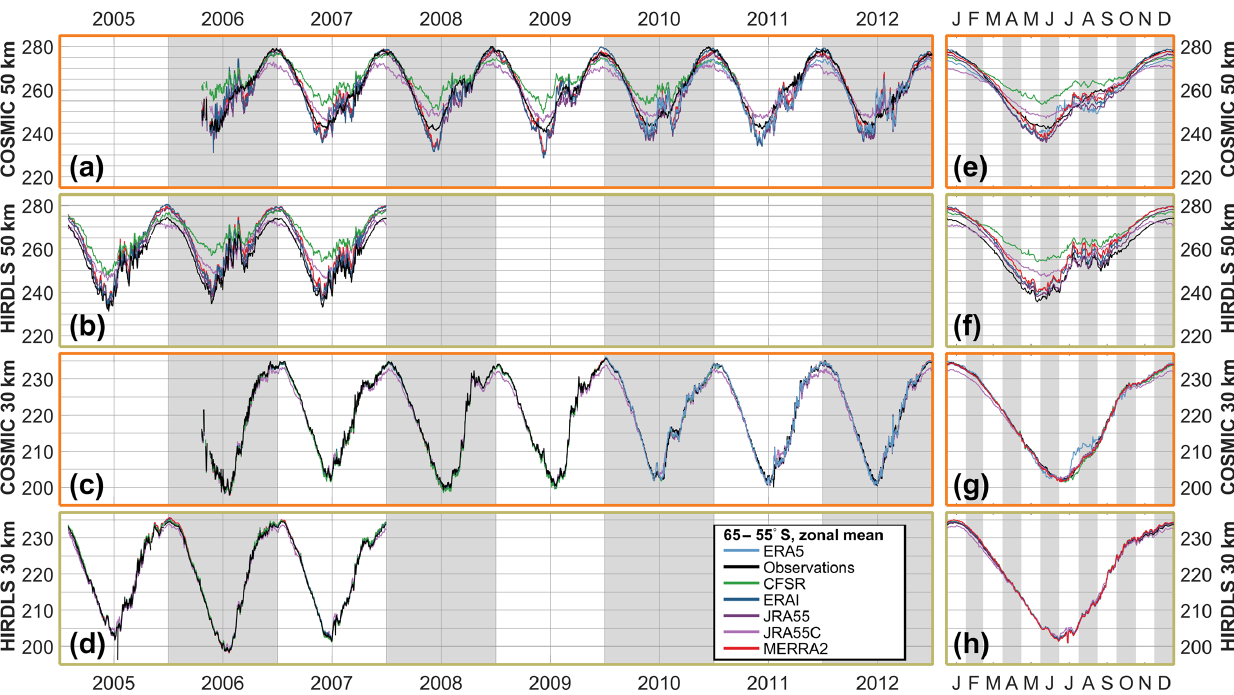
Figure 9. Time series of observed and sampled-reanalysis temperature, averaged over 55–65 ◦ S, at (a, b, e, f) 50km and (c, d, g, h) 30km in altitude. Panels (a) – (d) show time series over the period 2003–2012, and panels (e) – (h) the annual cycle derived from the extended time